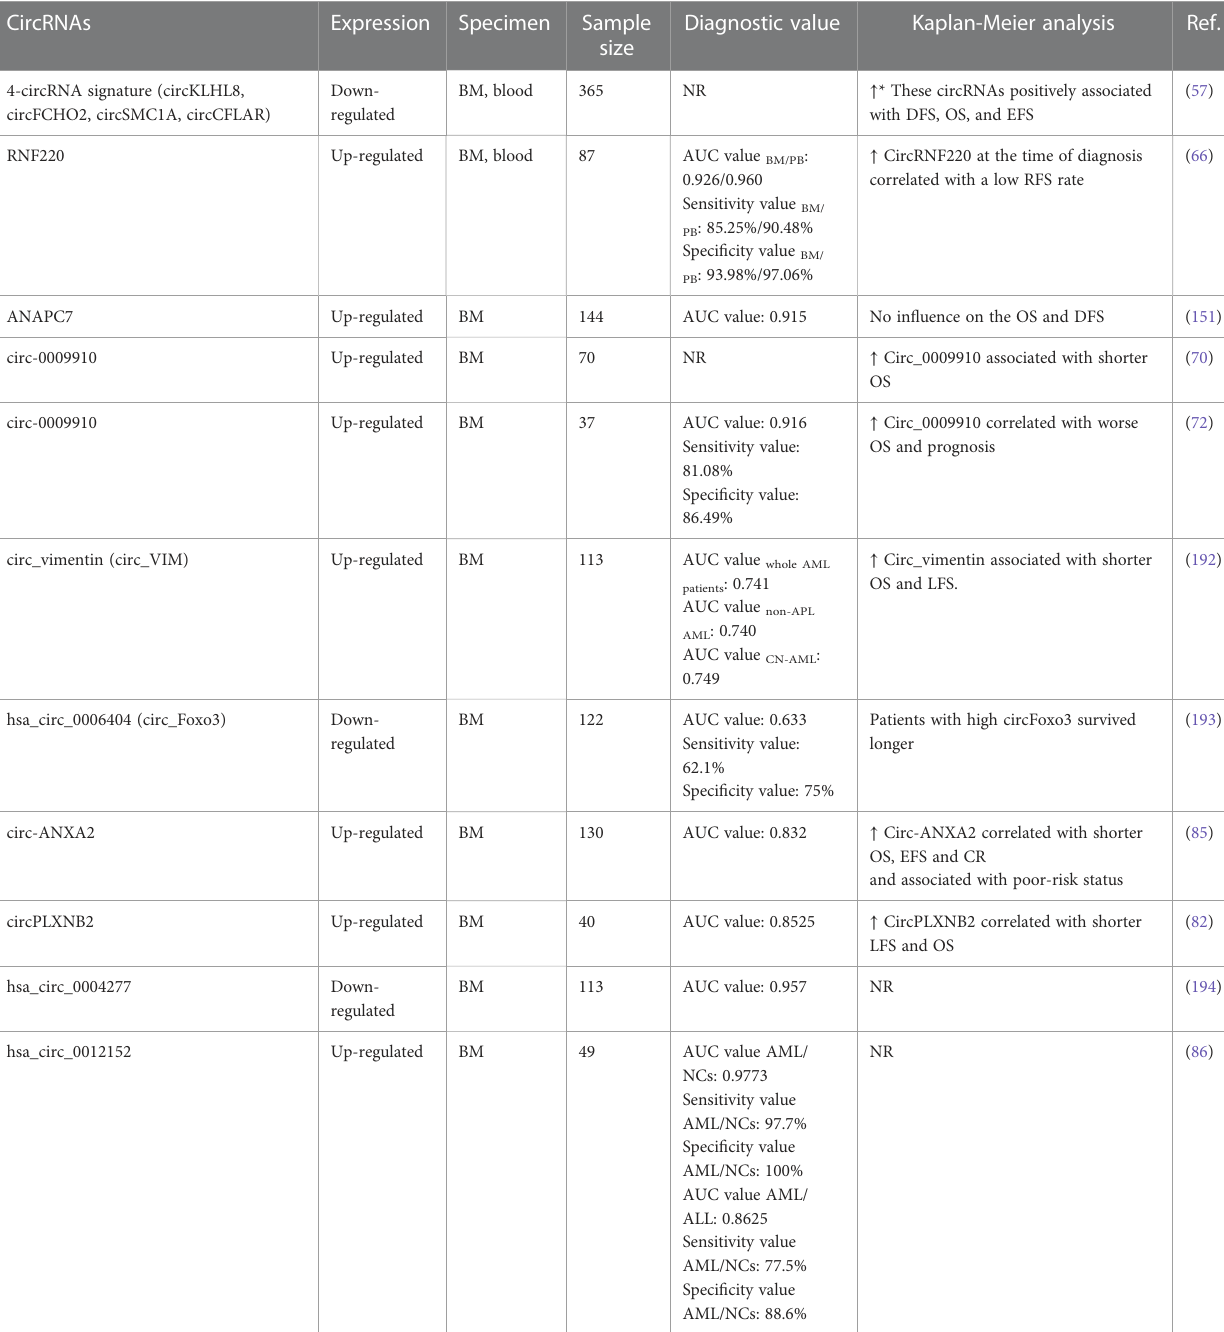
TABLE 2 Summary of candidate circRNAs that could be diagnostic and prognostic biomarkers of